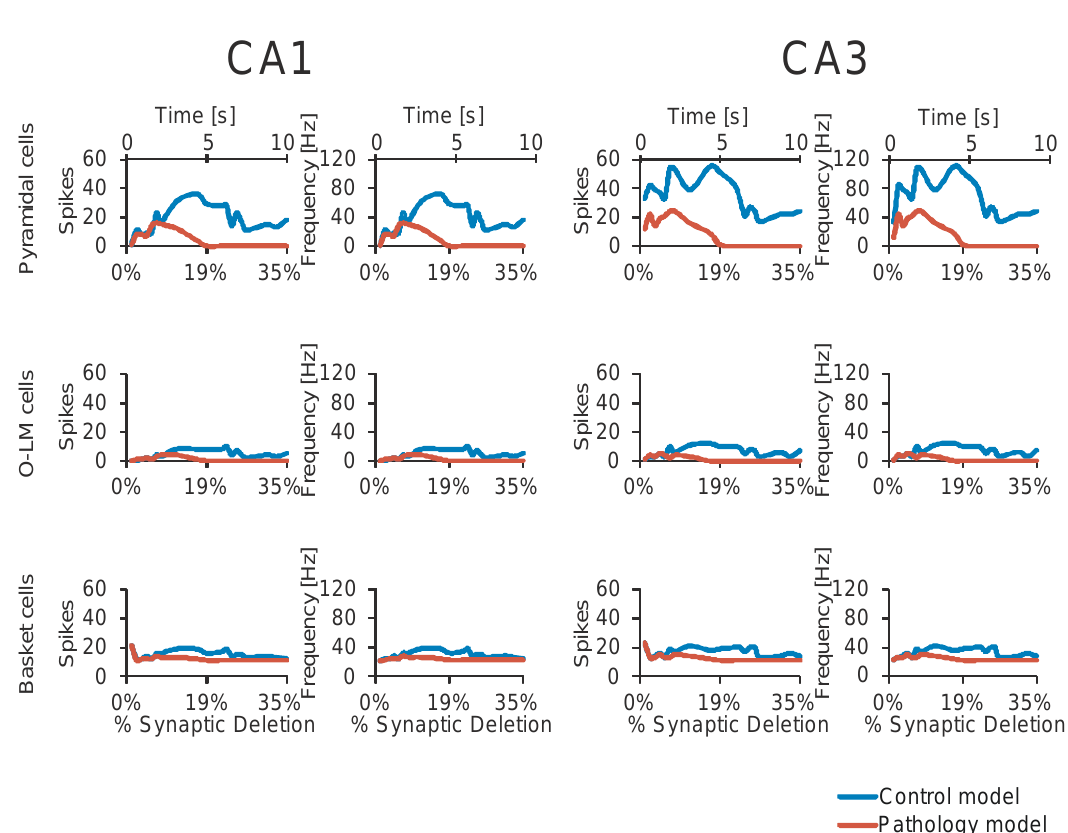
Figure 5. Relationship between number of spikes, frequency and synaptic deletion control and pathology models (pyramidal (P1-P8), OL-M (1 and 2) and basket (B1-B4) cells). The CA1 region is on the left and is the CA3 formation is on the right.